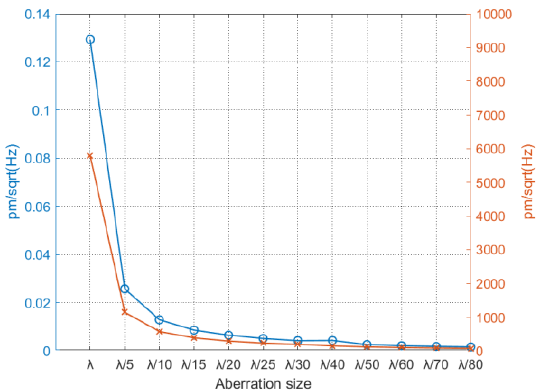
Figure 8. Aberration size of λ/80 - λ corresponds to the PSD average value of the resulting phase noise. The blue curve corresponds to the left ordinate, and the orange curve corresponds to the right ordinate.